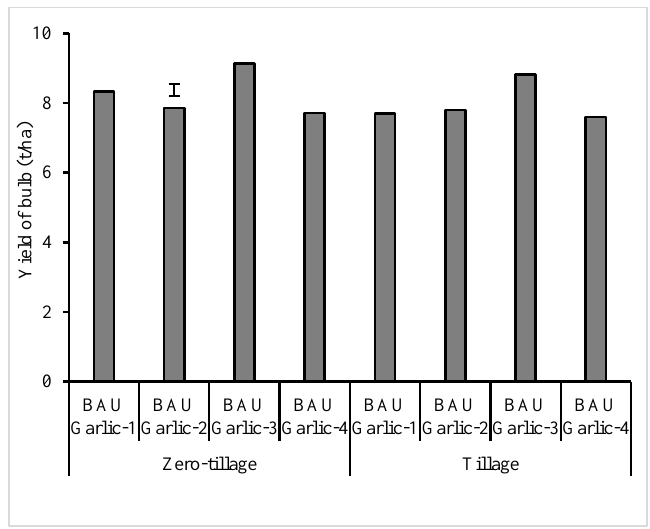
Figure 3. Combined effects of planting system and variety on yield of bulb. Vertical bar indicates LSD at 1% level of